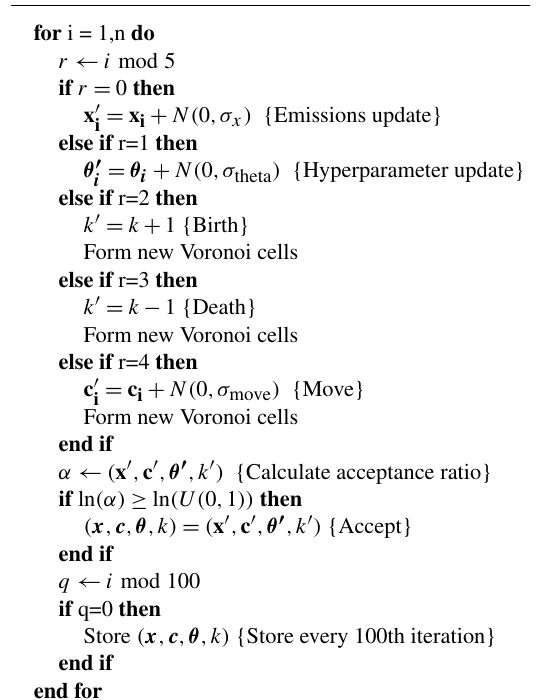
Algorithm 1 Reversible-jump pseudo